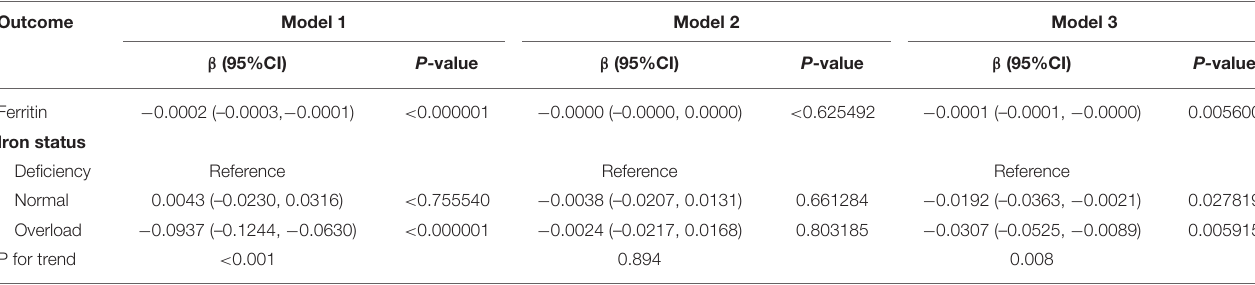
TABLE 2 | Relationship between ferritin and